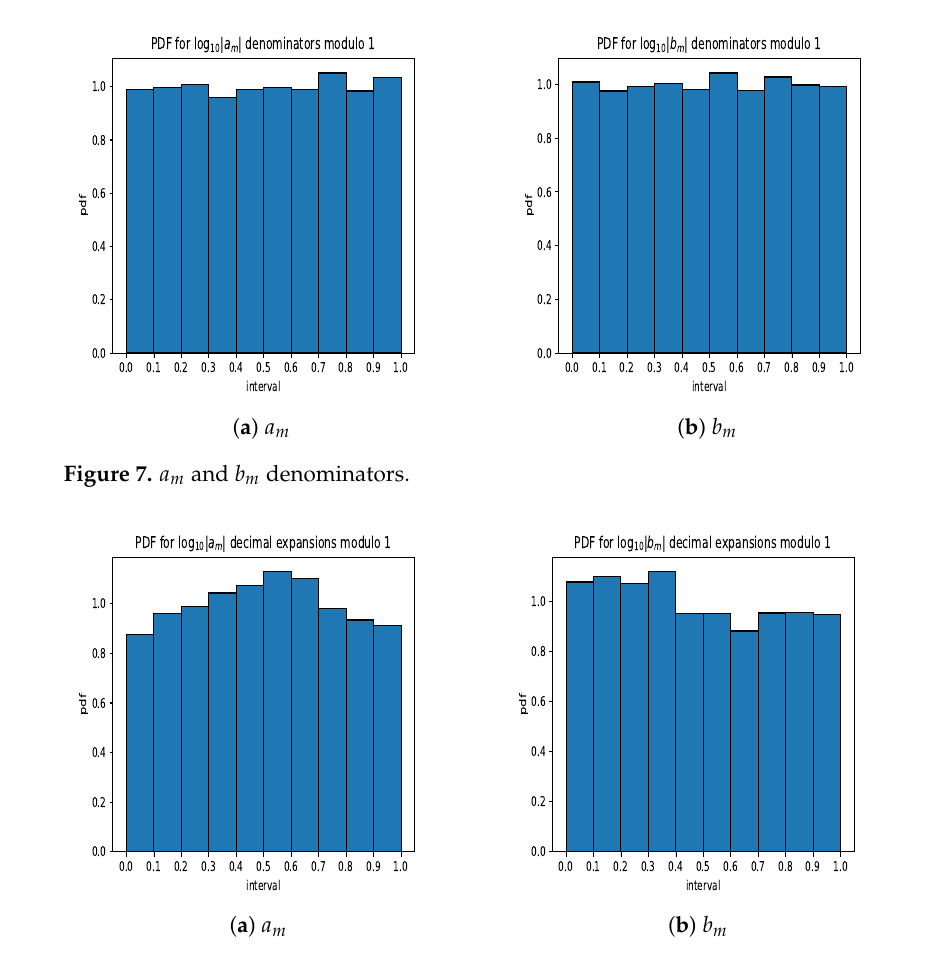
Figure 8. a m and b m decimal